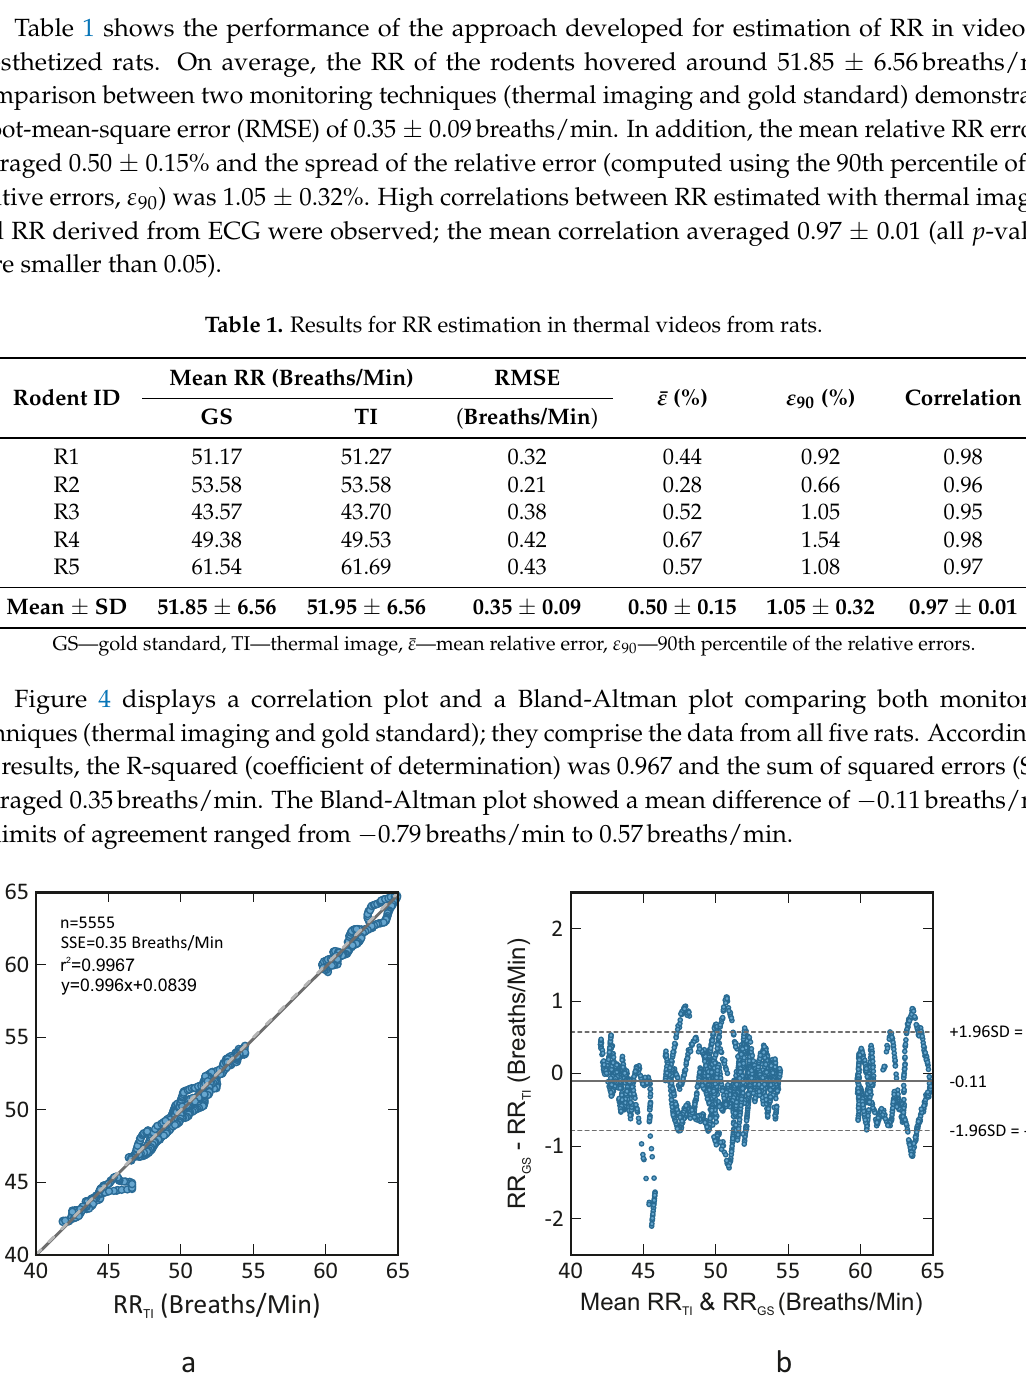
Figure 4. Correlation plot ( a ) and Bland-Altman plot ( b ) comparing RR assessed using thermal imaging (RR TI ) and RR assessed using ECG (RR GS ); the plots comprise the data of all five rats. The former shows a R-squared of 0.967 and a sum of squared errors of 0.35breaths/min. The latter demonstrates a bias of − 0.11breaths/min (solid line) and the 95% limits of agreement vary between − 0.79breaths/min and 0.57breaths/min (dashed